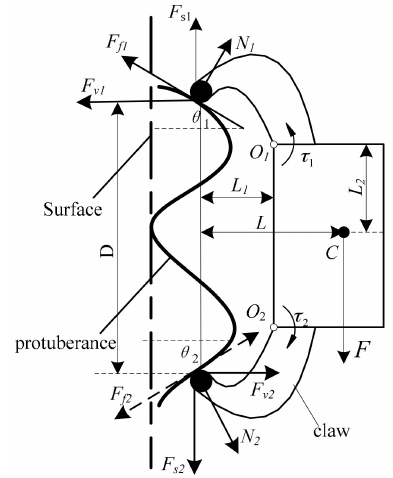
Figure 5. Analysis of stresses on hooked